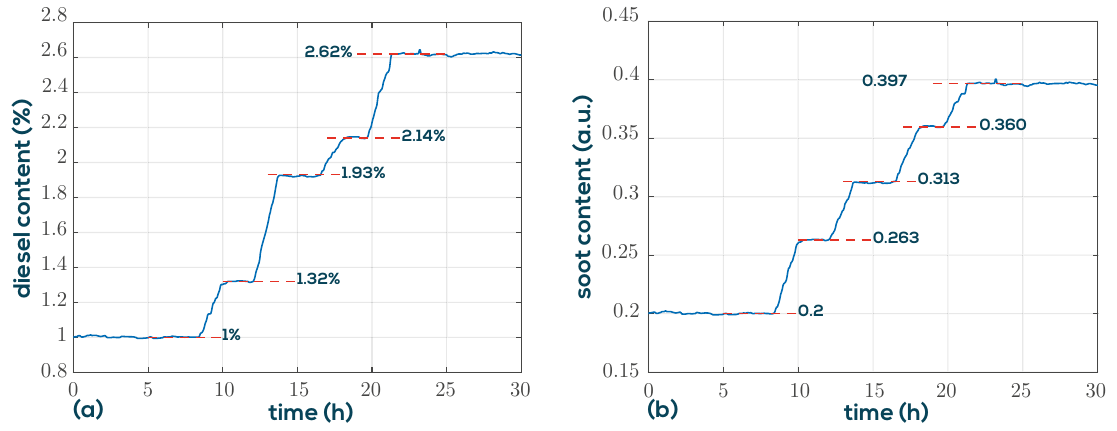
Figure 12. Resulting diesel concentrations ( a ) and soot equivalents ( b ) using a simple linearized mixing model. The dashed lines indicate theoretical